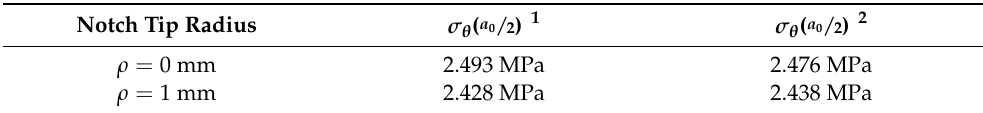
Table 2. TCD results of a basic study on double-notched V-plate ( W = 10 mm, a = 1 mm, 2 α = 90 ◦ ) in plane strain